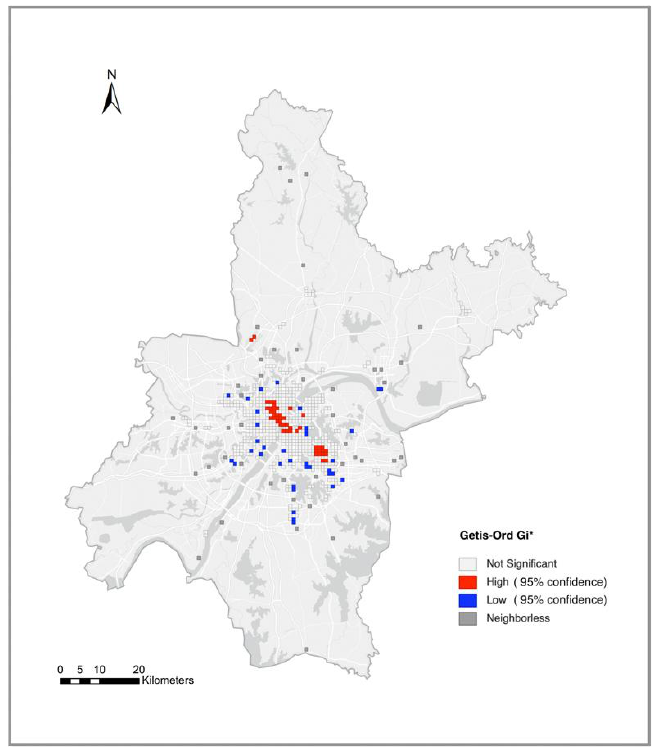
Figure 8. Hot-spot analysis (Getis-Ord Gi*) results of high-risk places in